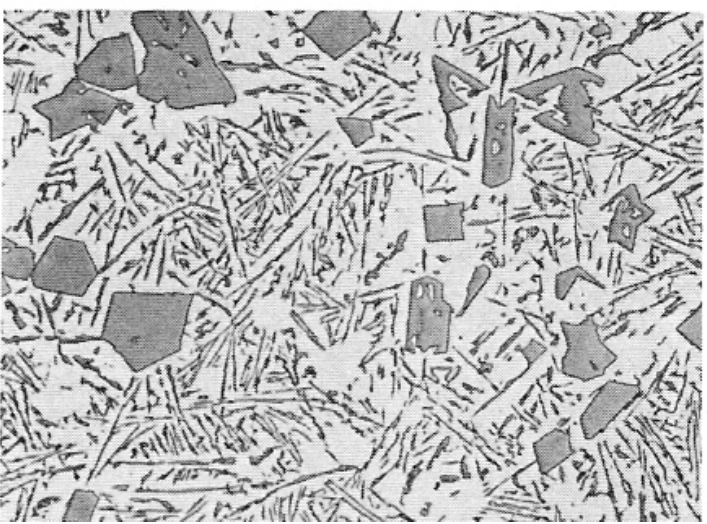
Figure 6. Hypereutectic alloy showing primary Si cyrstals and unmodified Si eutectic matrix.